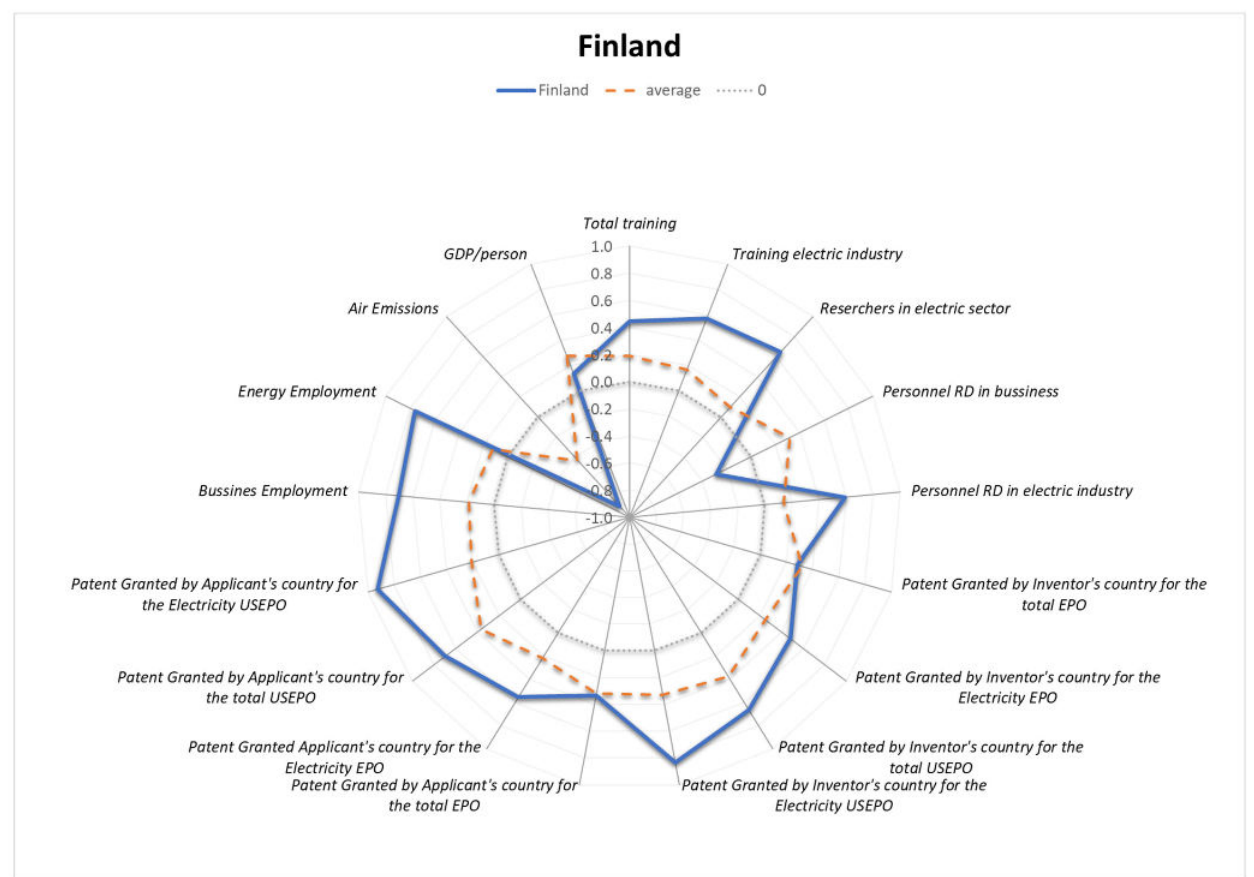
Figure 16. Synergy and trade-off occurrence—FI. Source: Authors’